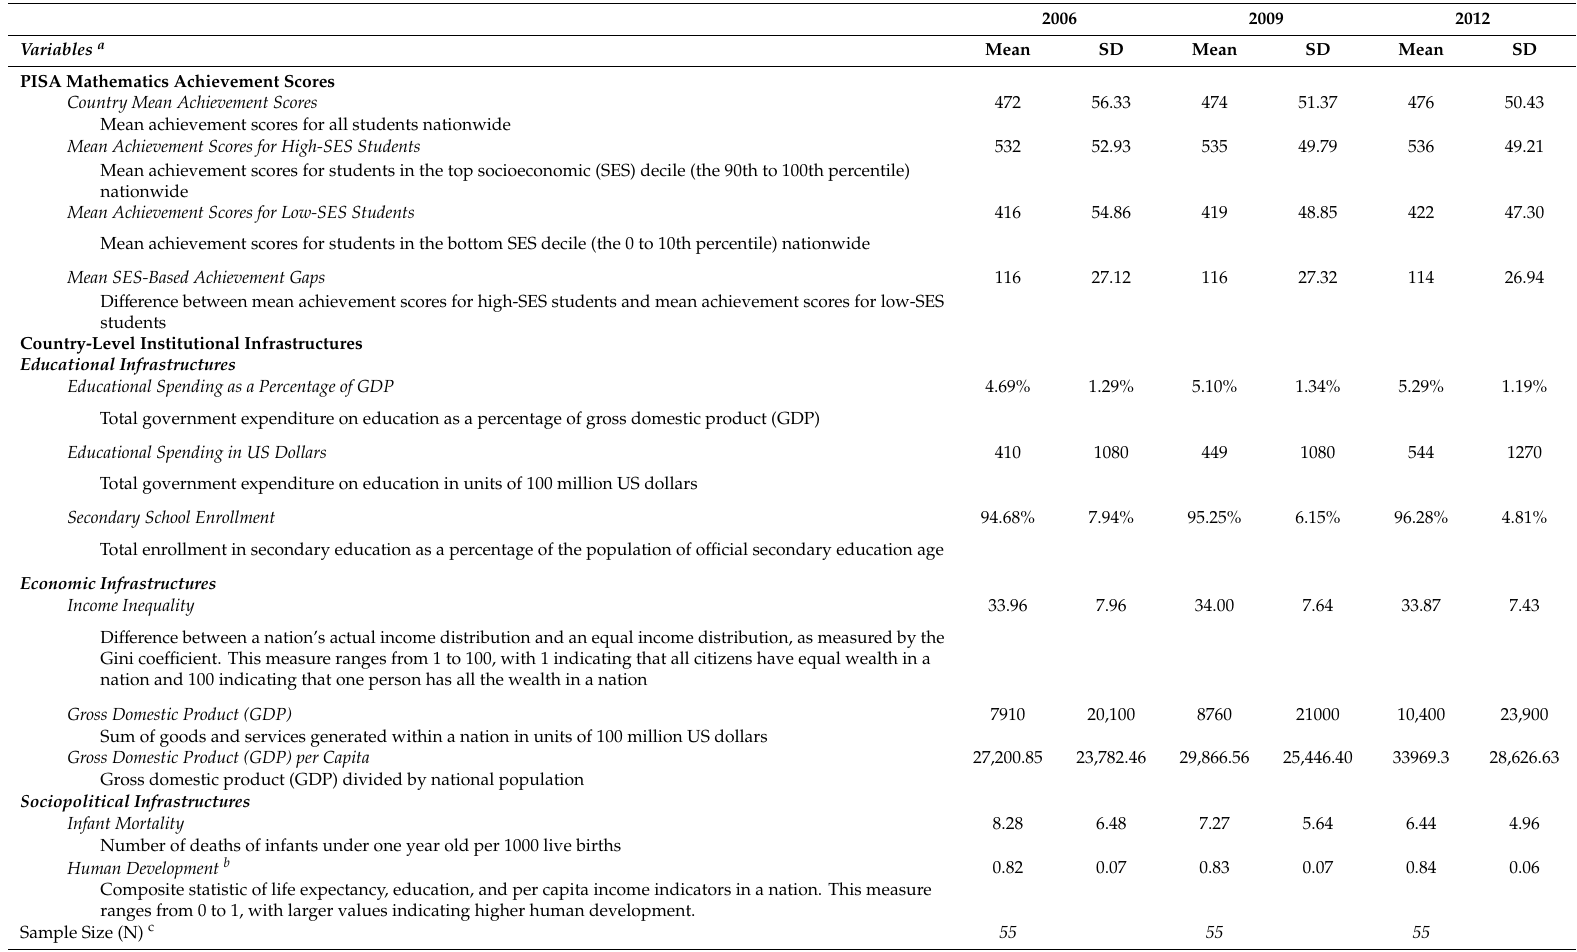
Table 1. Description of